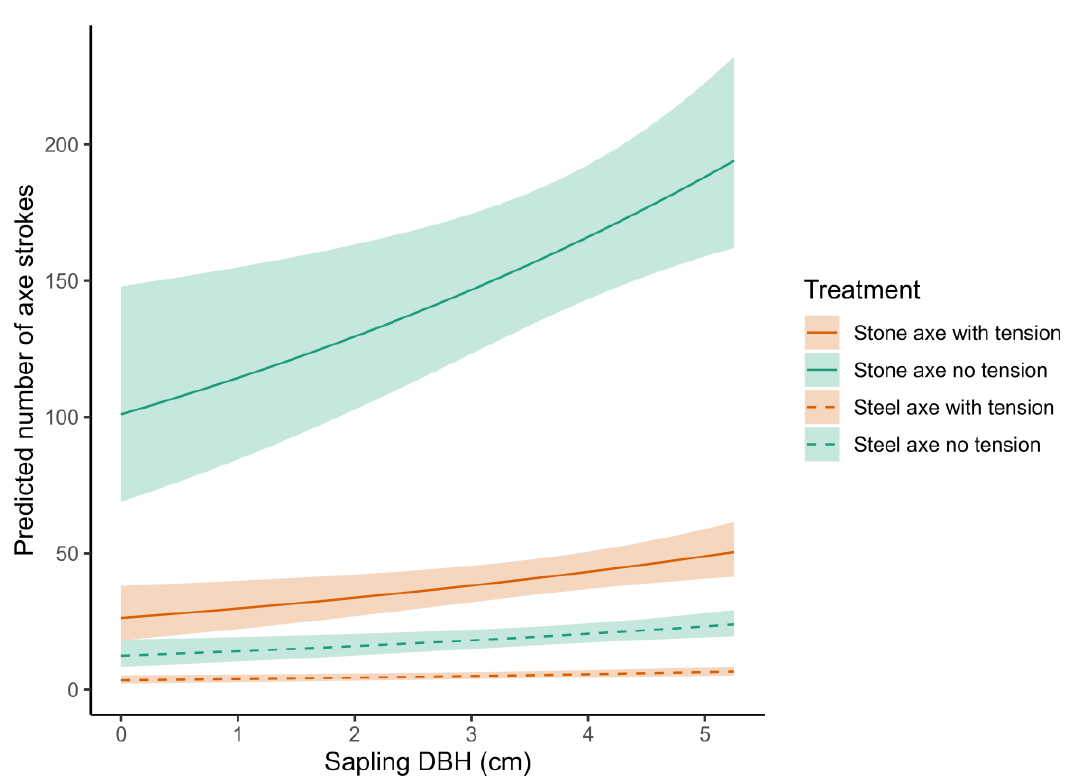
Figure 3. Predicted number of felling strokes from the GLMM (Table 1) as a function of tree DBH partitioned across all treatment and axe type combinations.